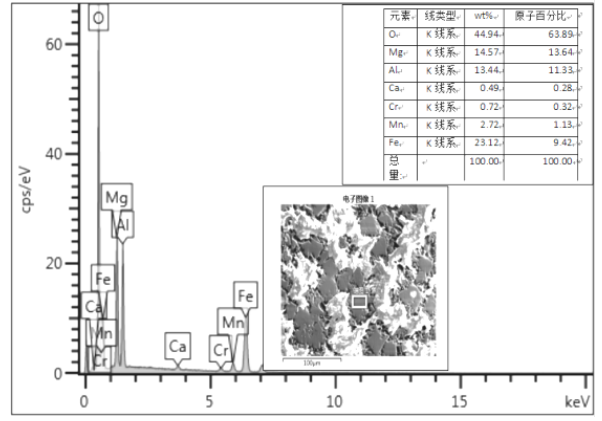
Figure 12: EDS energy spectrum of the reconstructed steel